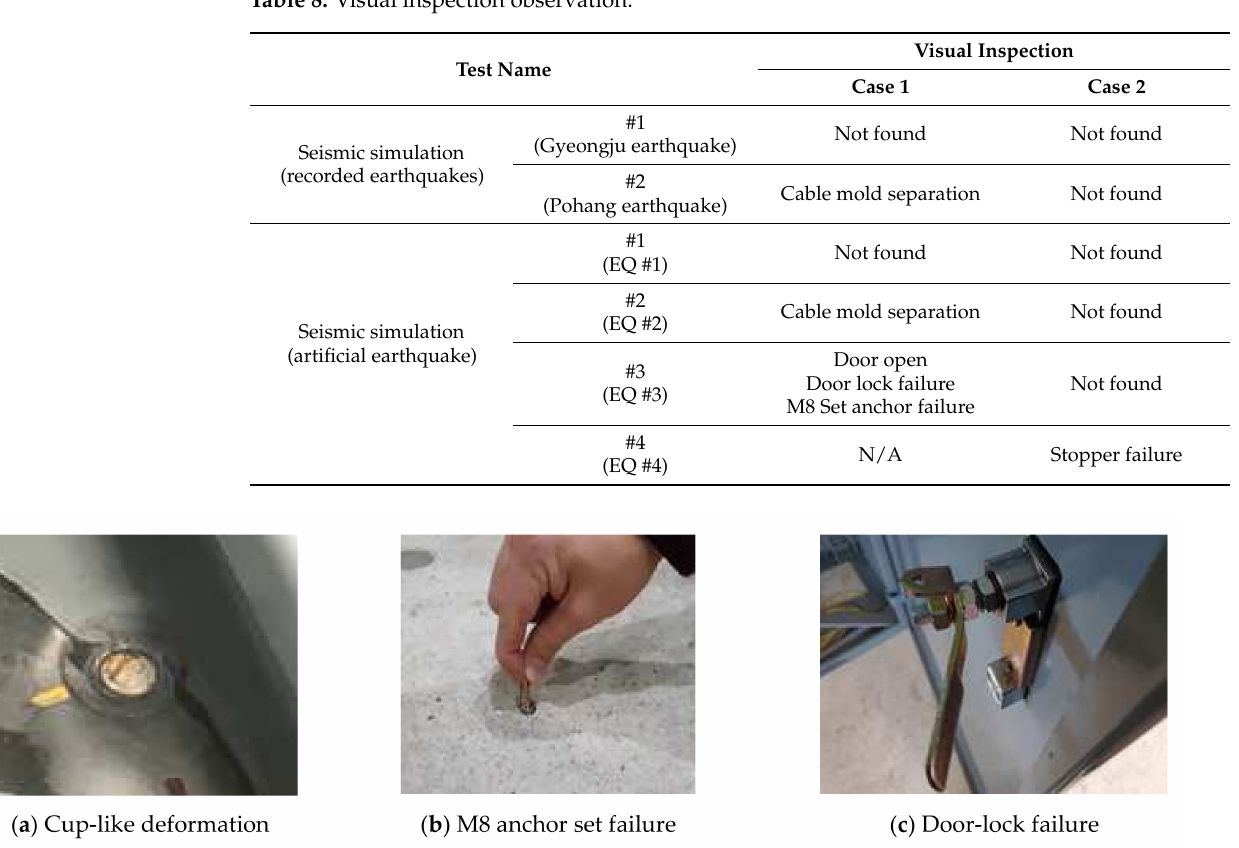
Figure 7. Visual inspection modes. Table 8. Visual inspection observation.